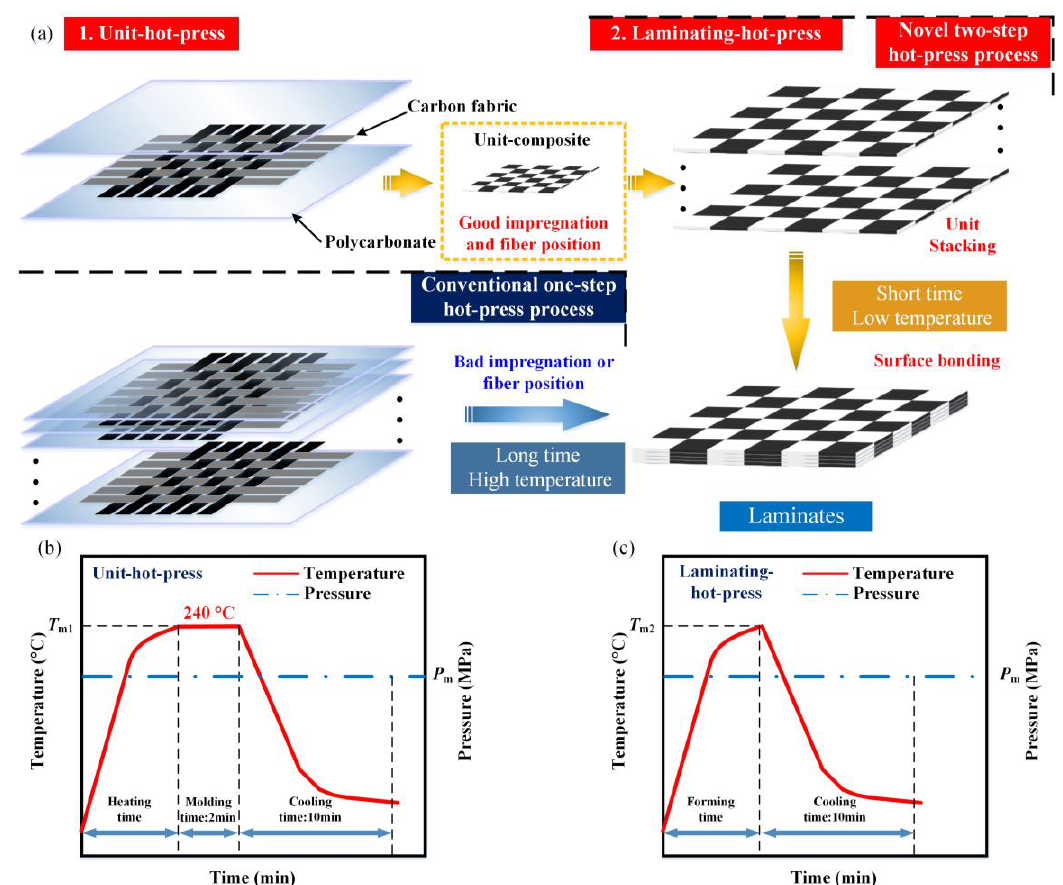
Figure 1. The schematic diagram of multi-CFPL fabrication using the two-step hot-press process: ( a ) Main operation step illustration; ( b ) the molding history of the unit-hot-press, in which T m1 is the hot-press temperature and P m is the hot-press pressure; ( c ) the molding history of the laminating-hot-press, in which T m2 is the forming temperature.